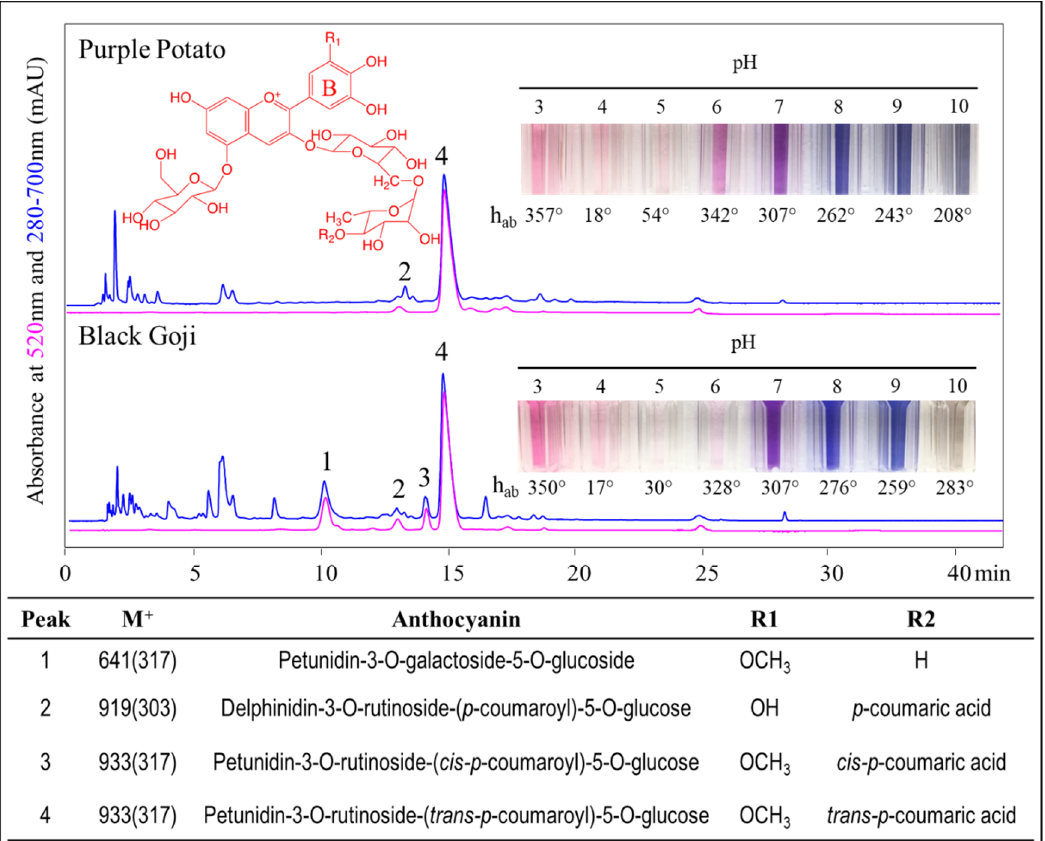
Figure 1. Purple potato and black goji anthocyanin extracts chromatograms at 520 nm and 280–700 nm, and their color expression at different pH.